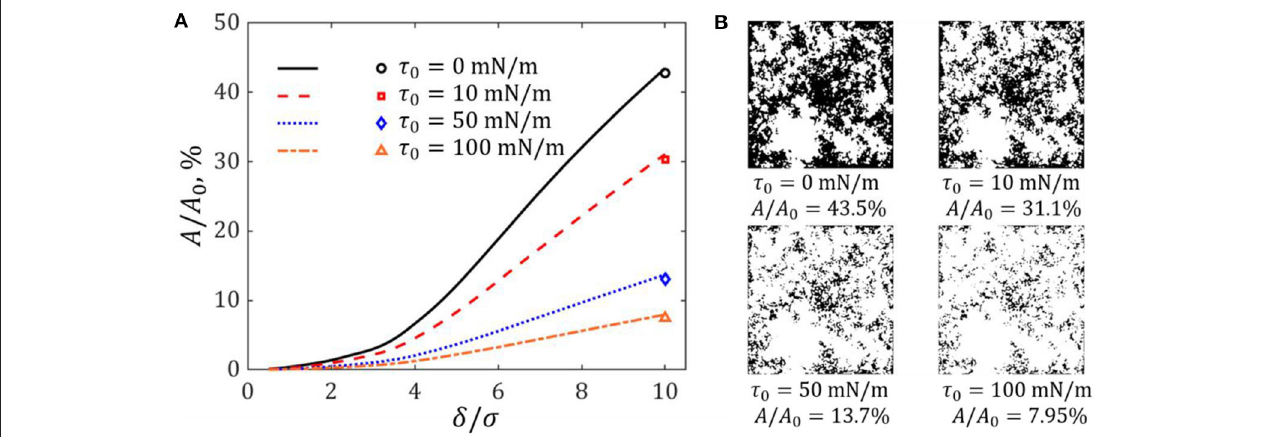
FIGURE 8 | (A) Variations of real contact area with respect to the indentation depth for the cases of different membrane/surface tension. Scatter symbols are the real contact area after correction operation for a specified displacement δ = 10 σ . (B) Images of contact regions under the displacement δ = 10 σ (black zone is the contact region).